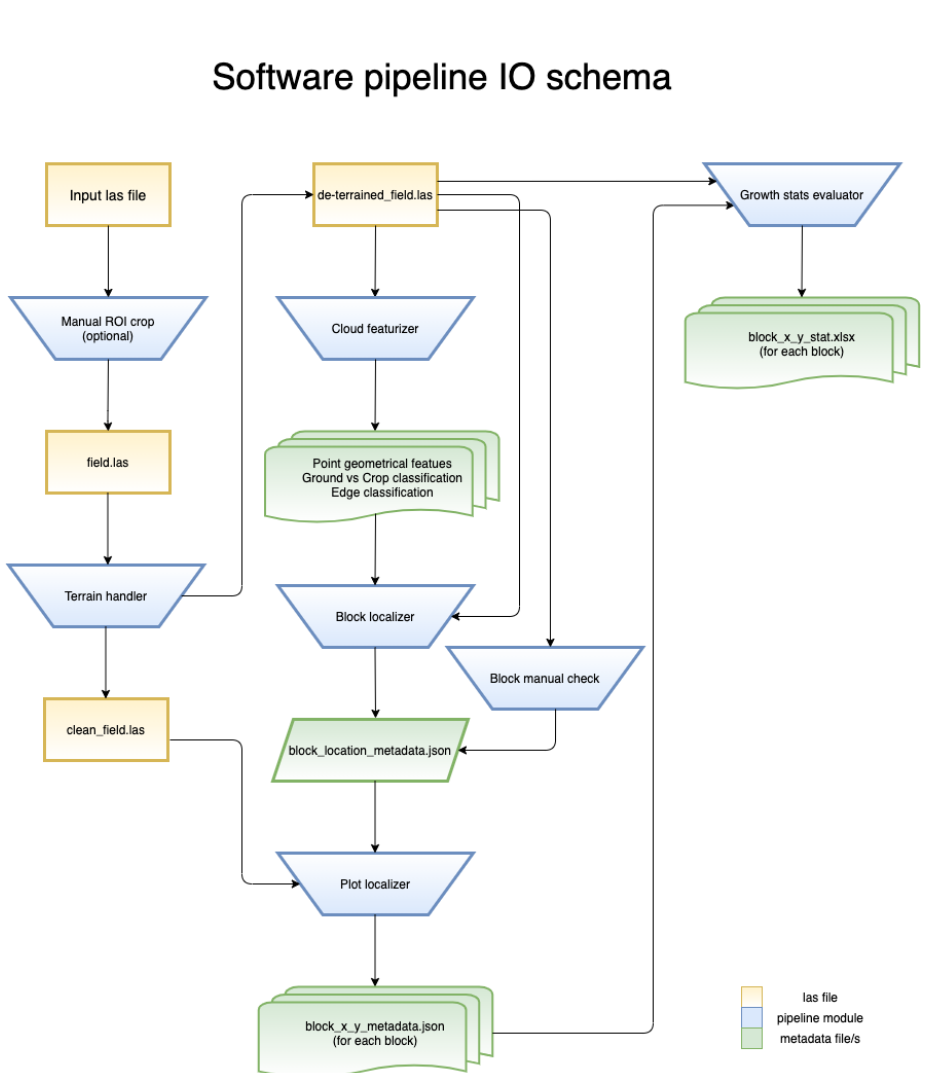
Figure 3. Novel point-cloud processing algorithm